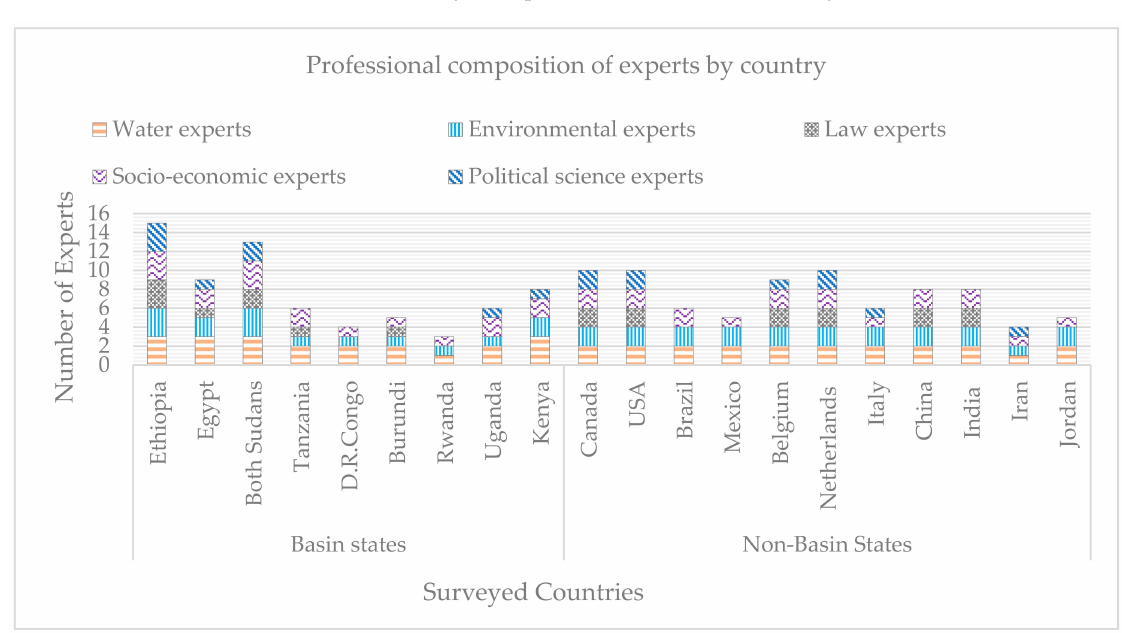
Figure 3. Country, number, and profession composition of experts responded the